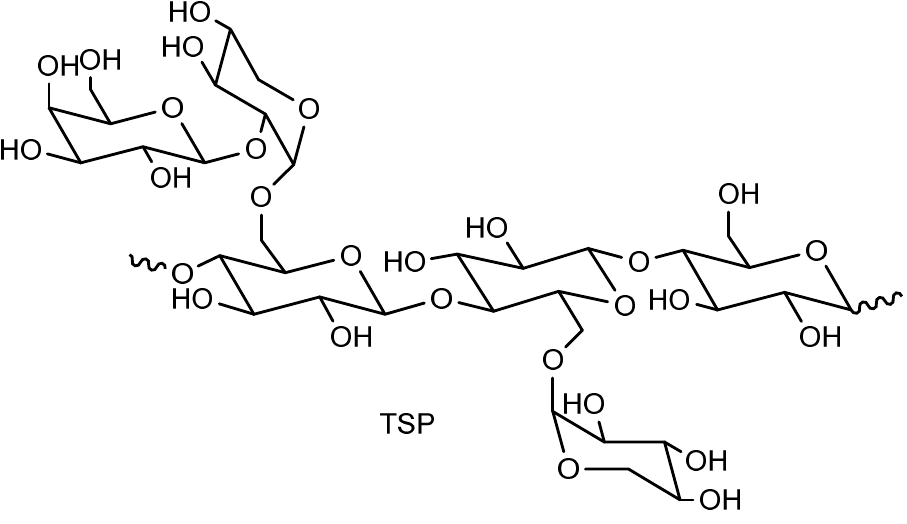
Figure 3. Fragment of TSP (tamarind seed polysaccharide).